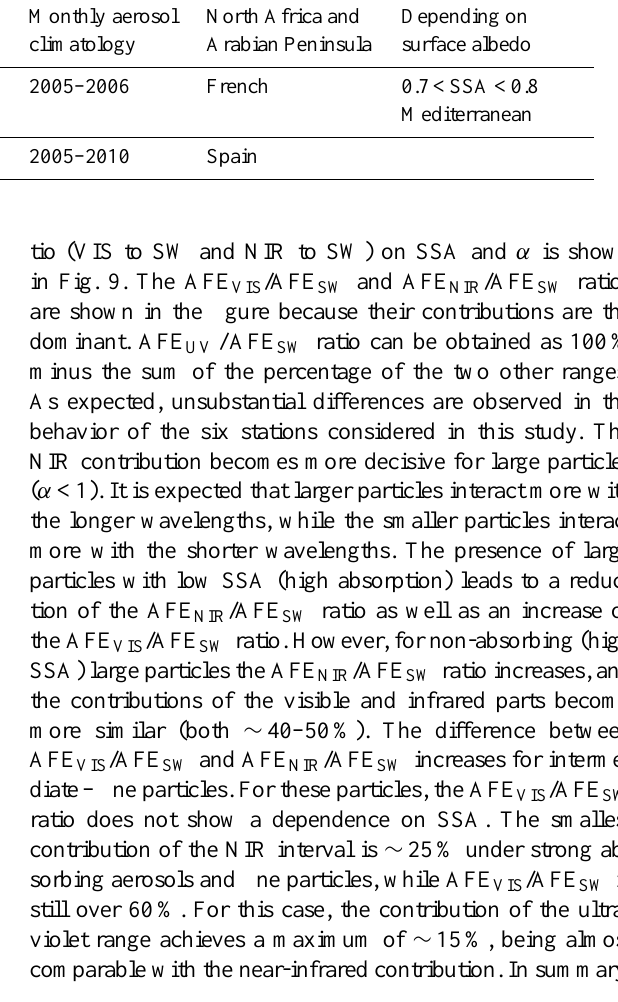
in Fig. 9. The AFE VIS /AFE SW and AFE NIR /AFE SW